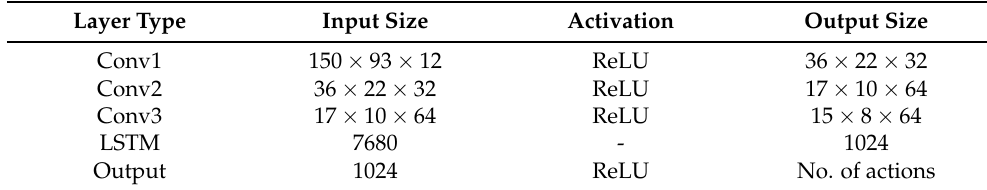
Table 1. DRQN model architecture details.